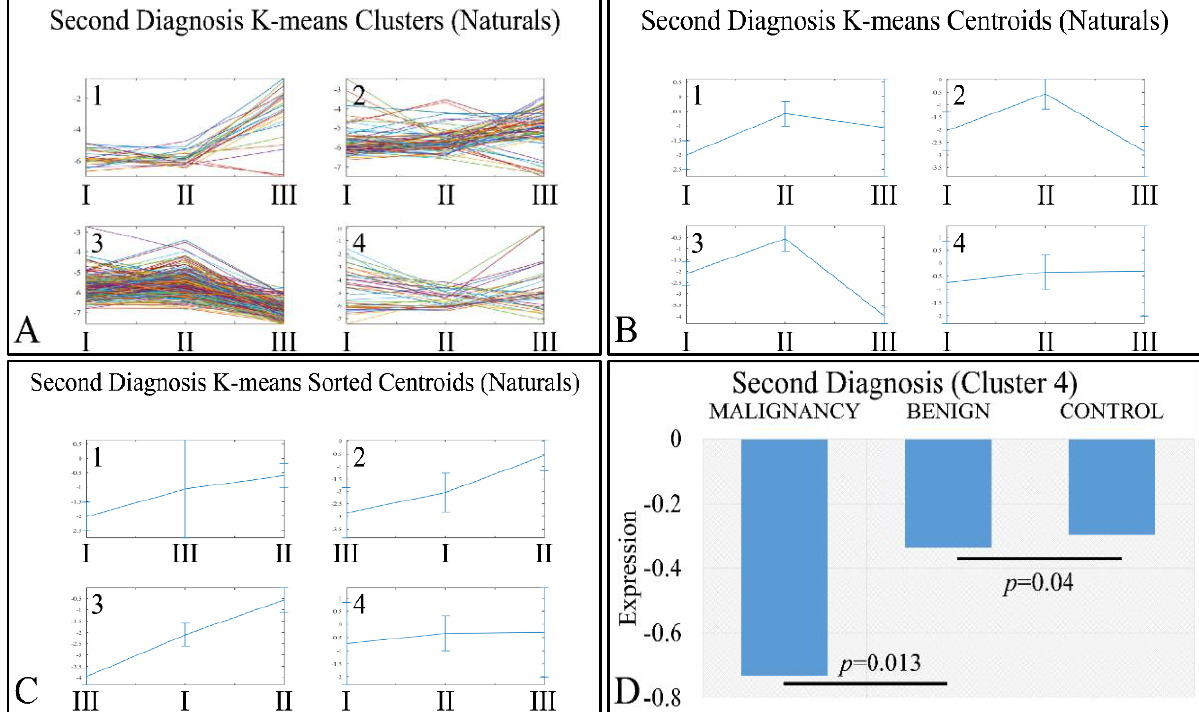
Figure 9. K-means clustering of DE miRNAs with respect to second diagnosis (controls, benign or malignant tumors), presented with the respective clusters ( A ), the centroids ( B ) and the sorted centroids ( C ). Cluster 4 manifested an ascending pattern from malignant tumors to controls ( D ). The expression levels were found to be significantly different between malignant and benign tumors, as well as between benign tumors and controls (Legend: I: Malignancy, II: Benign, III: Controls. Expression values range in the negative domain because we have used the log 2 -transformed natural values, in order to better visualize the differences).